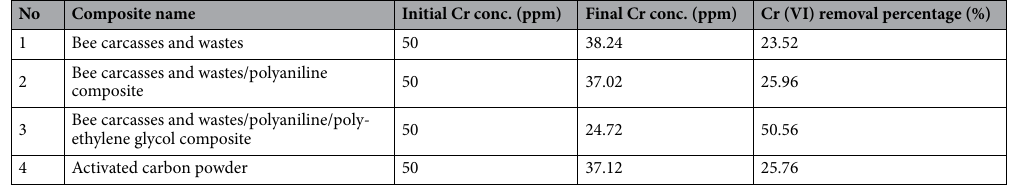
Table 1. Results of chromium separation using bee carcasses and wastes and their composites with polyaniline (contact time 30 min, pH = 6, adsorbent amount 2